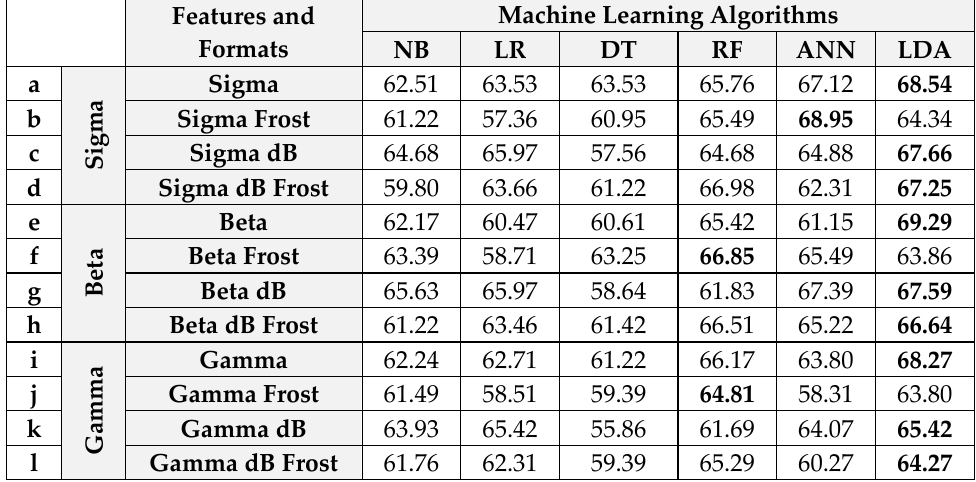
Table 3. Classification accuracies for S, B, and G, considering all formats and algorithms.